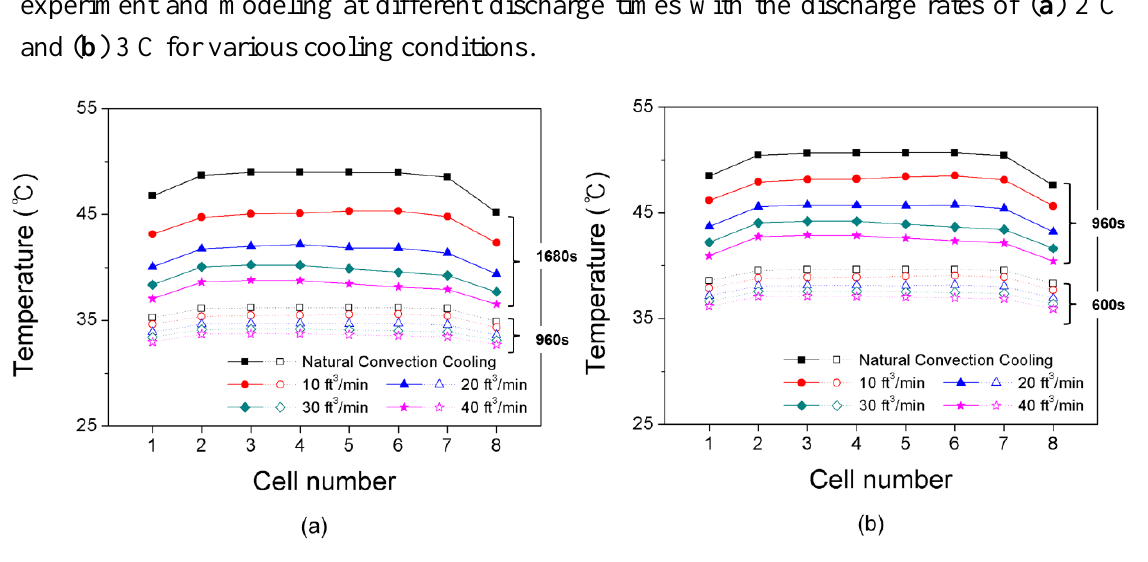
Figure 10. Temperature distributions of the LIB cells within the module at the discharge time of 1680 s with the discharge rate of 2 C for the forced convection cooling with the volumetric flow rates of ( a ) 10 ft 3 ·min −1 , ( b ) 20 ft 3 ·min −1 , ( c ) 30 ft 3 ·min −1 , and ( d ) 40 ft 3 ·min −1